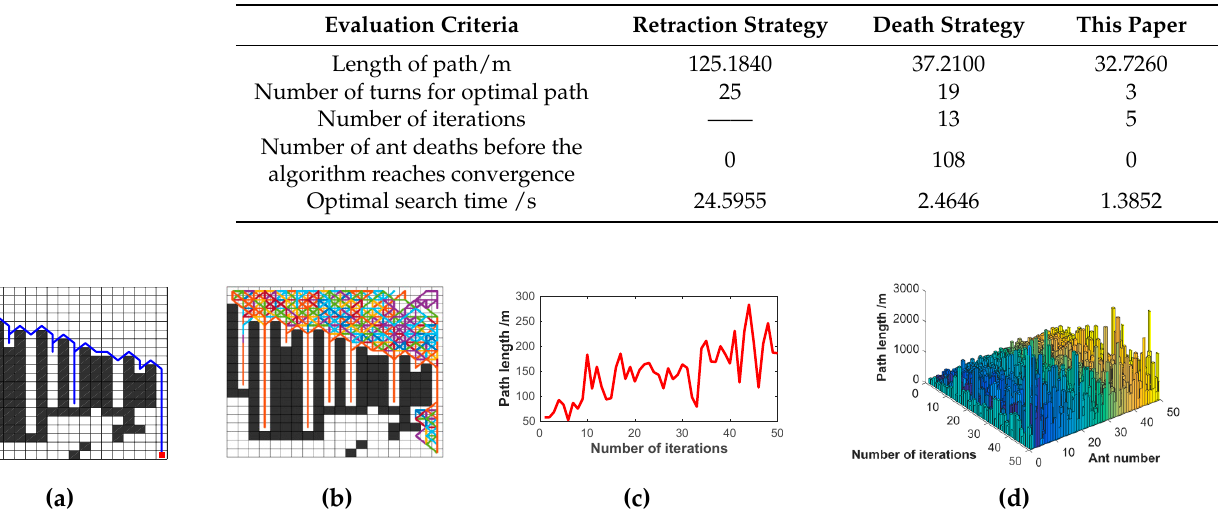
Figure 13. Retraction strategy optimisation path diagram; ( a ) Optimal path diagram; ( b ) All ants’ paths diagram; ( c ) Iterative diagram of the optimal path; and ( d ) Iterative diagram of ants’ paths.